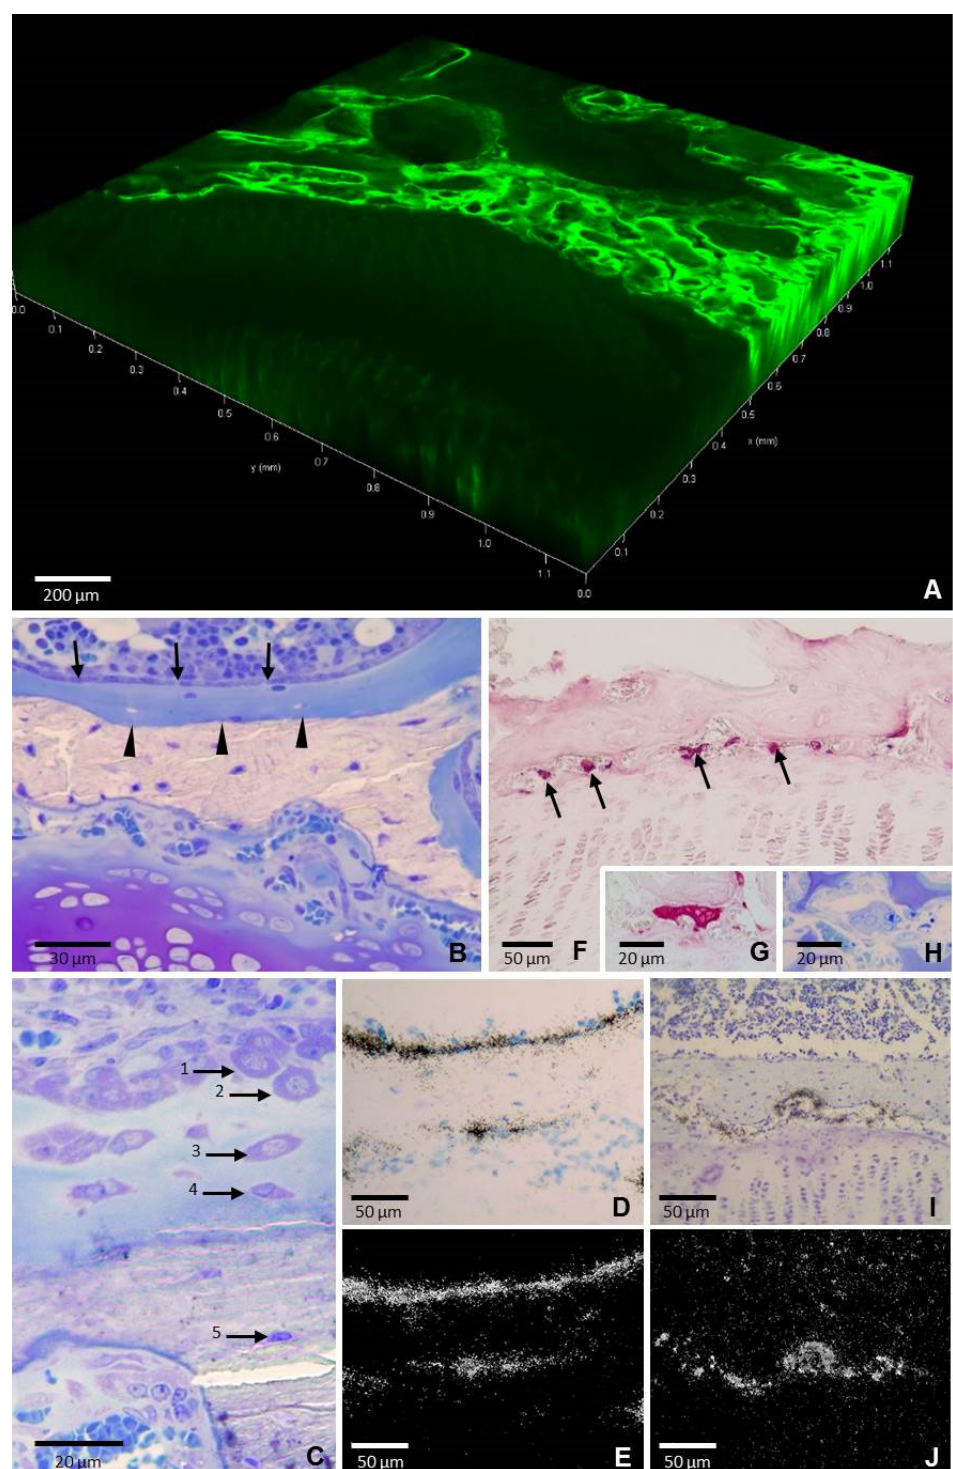
Figure 3. Sections of the tibial epiphysis of a 24-day-old rat. ( A ) Confocal microscopy showing a 3D projection reconstructed from z-stack images of bone tissue labeled with calcein. Fluorescence (green) is located around the blood vessels and this gives rise to an arrangement of circles whereas the underlying growth plate cartilage is completely devoid of fluorescence. ( B ) Semithin section stained with toluidine blue showing a continuous monolayer of cuboidal osteoblasts (arrows) on the surface of the bone plate. Below the osteoblasts is a thick layer of blue-stained osteoid and beneath it, there is the unstained mineralized bone. A sharp boundary between osteoid and mineral- ized bone is observed (arrowheads). ( C ) Semithin section stained with toluidine blue showing the gradual transformation of the phenotype of the osteoblasts that became trapped in the osteoid (1–2) to osteoid-osteocytes (3–4) and osteocytes (5). ( D ) Bright field and ( E ) dark field images of a section hybridized with a 35 S-labeled riboprobe for osteocalcin showing a continuous band of positive signal on the surface of the upper side whereas only some scattered cells are positive at the lower side. ( F ) TRAP-positive osteoclasts at the narrow space between the bone plate and the growth plate cartilage (red stained, arrows). ( G ) Higher magnification of a TRAP positive cell. ( H ) Image of the same cell in a semithin section stained with toluidine blue. ( I ) Bright field and ( J ) dark field images of a section hybridized with a 35S-labeled riboprobe for gelatinaseB showing that expres- sion is restricted to the lower side. Osteoblasts formed a continuous epithelium-like monolayer of cuboidal cells on the surface of the upper side. Directly underneath the layer of osteoblasts was a thick layer of osteoid and beneath the latter was the mineralized bone. Osteoid and mineralized bone could be distinguished in semithin sections by the positive toluidine blue staining of the former and the almost complete lack of staining of the latter, so that a sharp boundary